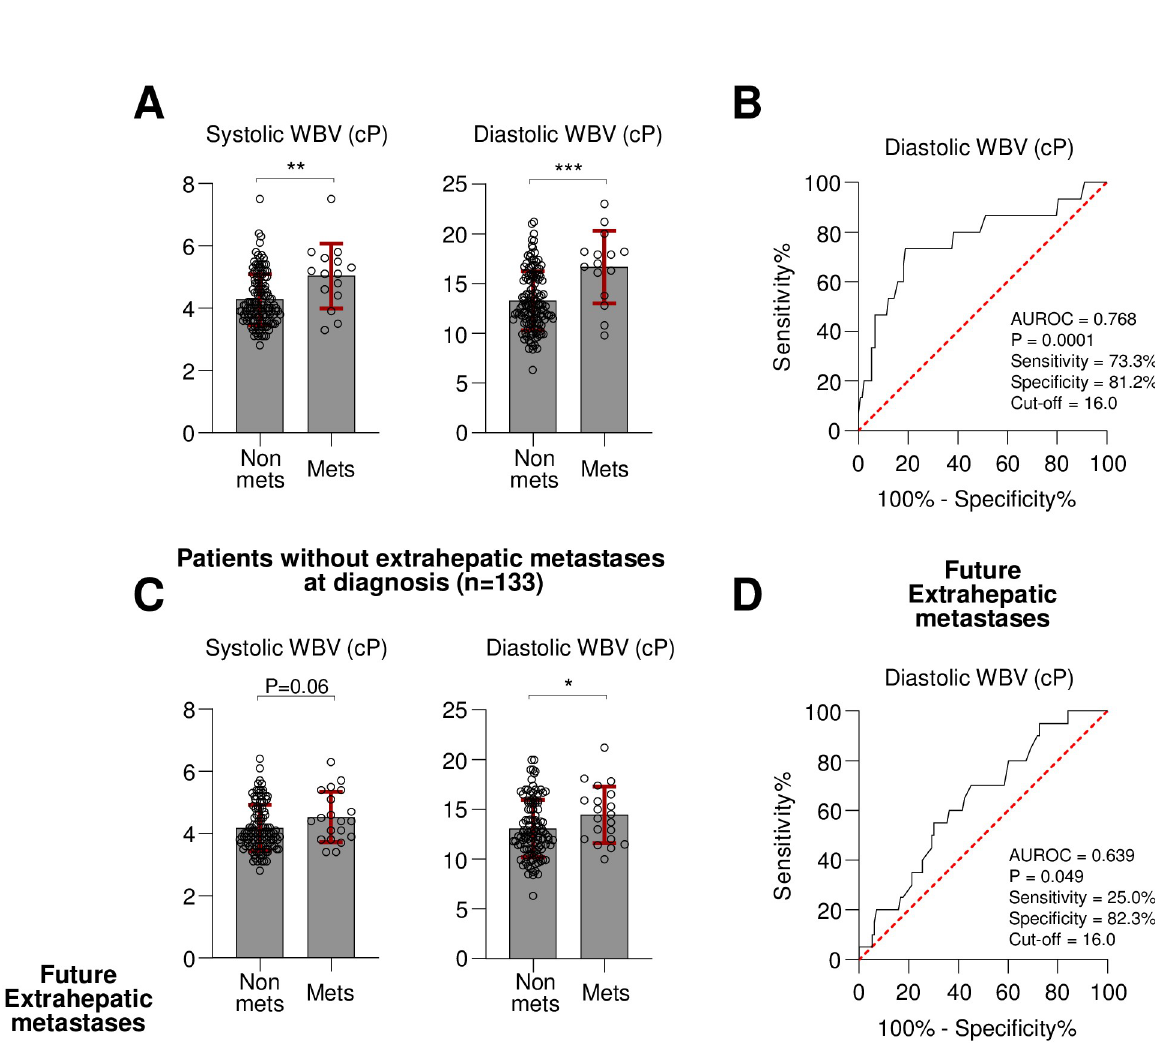
Fig 2. (A and B) All 148 enrolled patients were evaluated for subsequent analyses. (A) Comparison of systolic WBV (left) or diastolic WBV (right) between patients with non-metastases (non-mets) (n = 133) and metastases (mets) (n = 15) based on Mann-Whitney U test. (B) AUROC curve analysis was performed to determine the power of diastolic WBV in predicting metastases at diagnosis of HCC. (C and D) The 133 patients without metastases at diagnosis were evaluated for subsequent analyses. Future metastases were diagnosed during the follow-up periods in 20 patients. (C) Comparison of systolic WBV (left) or diastolic WBV (right) between patients with future non-metastases (non-mets) (n = 113) and future metastases (mets) (n = 20) based on Mann-Whitney U test. (D) AUROC curve analysis was performed to determine the power of diastolic WBV in predicting future metastases. � P < 0.05, �� P < 0.01, ��� P <